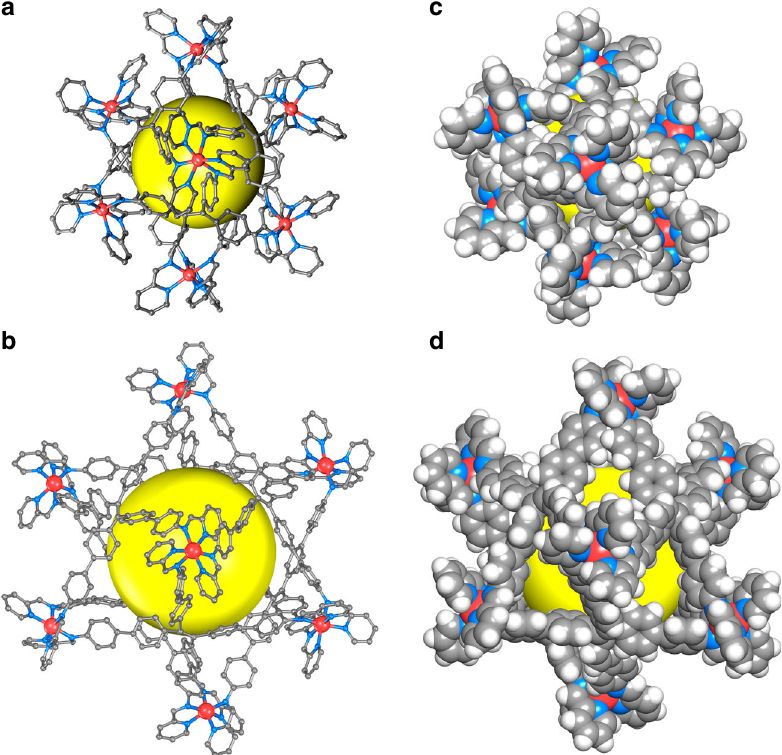
Fig. 2 Single-crystal X-ray structures. a TPE -1 , b TPE -2 ; c , d their space- fi lling models (the cavities are highlighted by yellow spheres). Color coding: Orange, Zn; Blue, N; Gray, C; White,